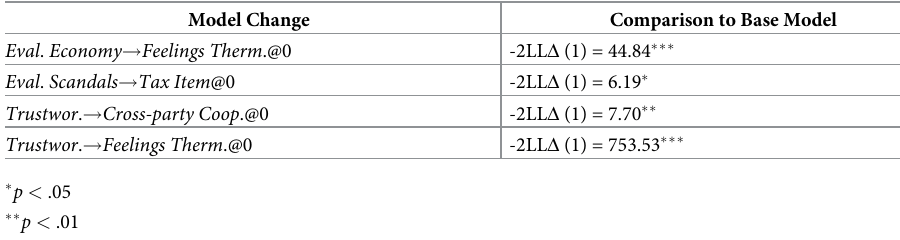
Table 7. Path removal model